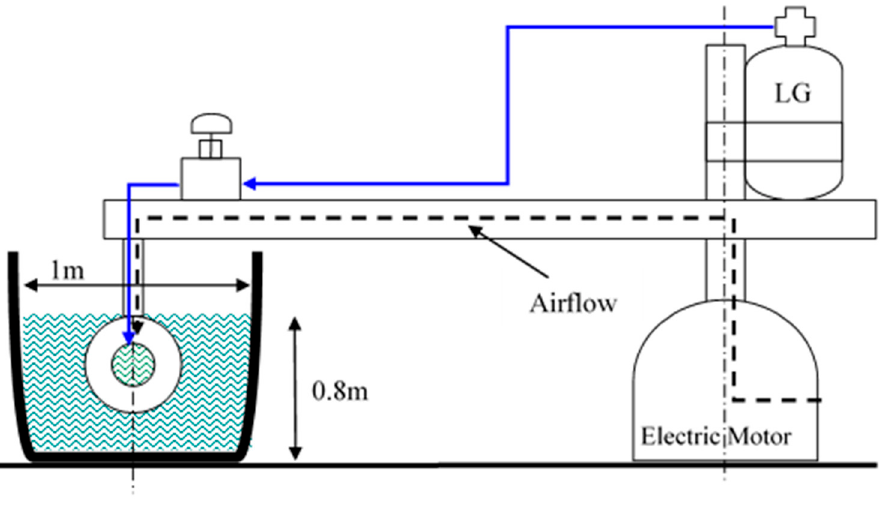
Figure 6. Schematic cross-sectional view of marine ramjet (MRJ) tow pool modified for boiling LG propulsion.